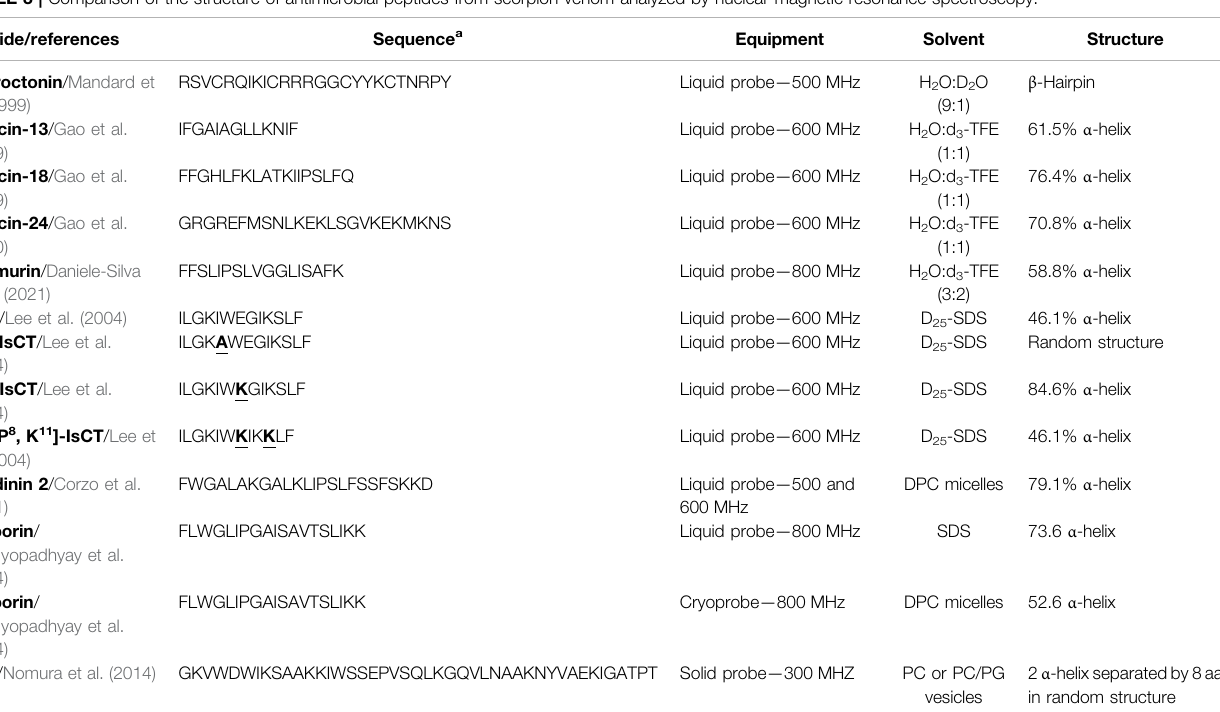
TABLE 3 | Comparison of the structure of antimicrobial peptides from scorpion venom analyzed by nuclear magnetic resonance